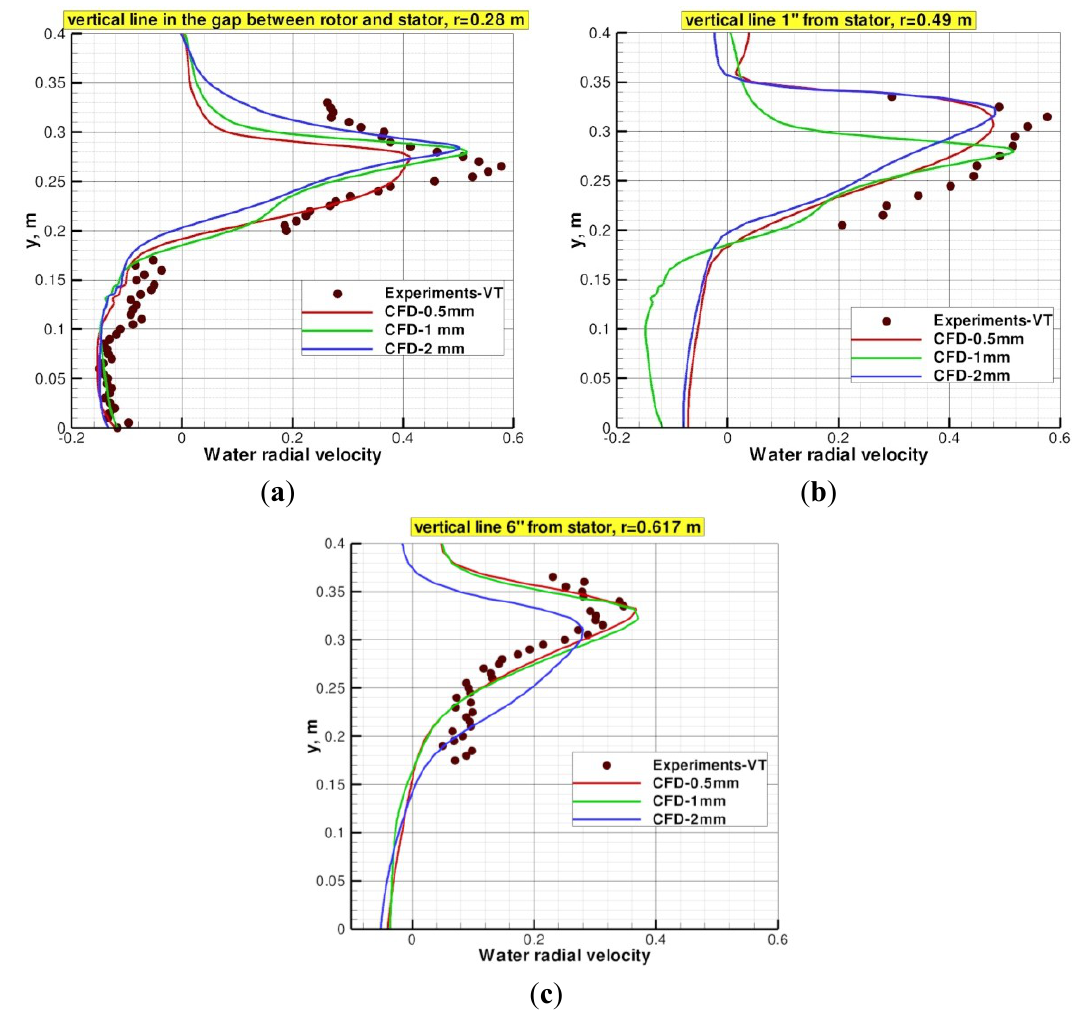
Figure 8. ( a ) Normalized water superficial radial velocity on a vertical line r = 0.28 m in the gap between the rotor and stator; ( b ) normalized water superficial radial velocity on a vertical line at radial distance 25.4 mm from the stator ring; and ( c ) normalized water superficial radial velocity on a vertical line at radial distance 152.4 mm from the stator